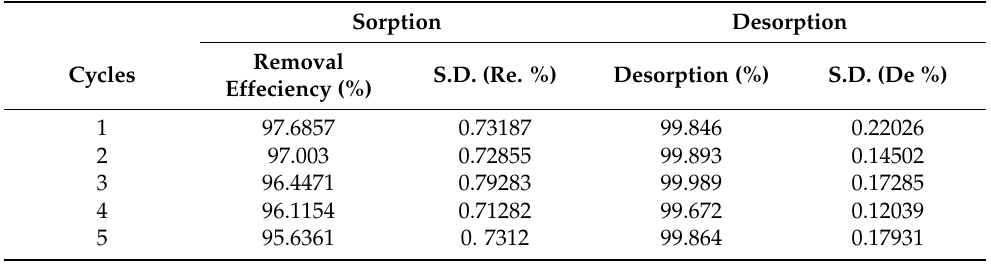
Figure 10. Desorption kinetics of uranium on CH-S sorbent. Table 7. Sorption and desorption recycling for the sorbent toward uranium (VI) ions.